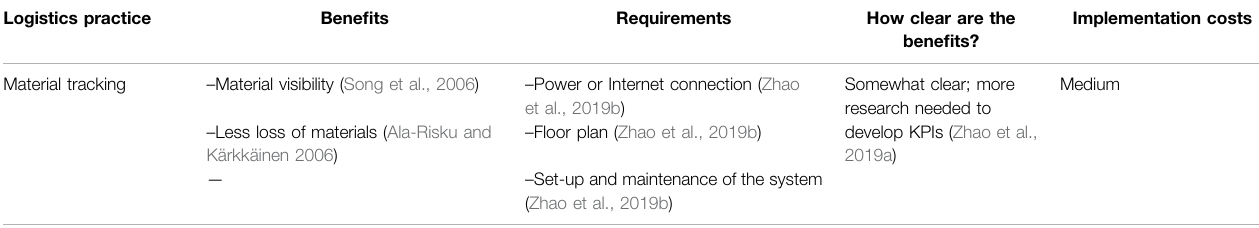
TABLE 1 | ( Continued ) Logistic practices used in construction, including their requirements and bene fi